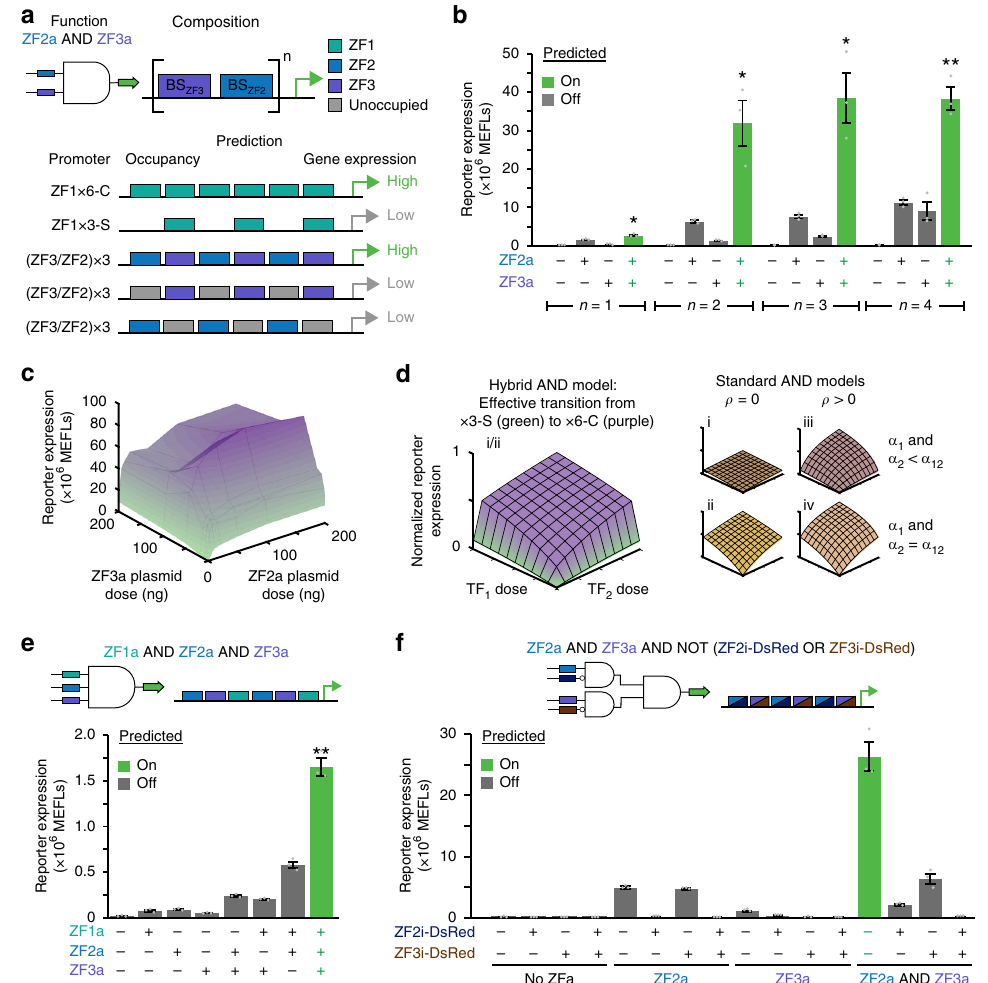
Fig. 8 Composing Boolean logic. a The cartoon summarizes a strategy for single-layer, promoter-based logic gates with ZF-TFs. We hypothesized that AND gate promoters could be designed by using multiple repeats of a paired ZF3/ZF2 motif. Full occupancy of this promoter by both ZF2a and ZF3a mimics a fully occupied x6-C promoter, and partial occupancy (with either ZFa alone) mimics an x3-S promoter. Thus, there is a large increase in gene expression when the promoter is occupied by two types of ZFa compared to one type. b Candidate two-input AND gates were constructed using one to four repeats of paired binding sites in the promoter. AND gate behavior is considered signi fi cant if reporter expression with both ZFa is greater than the sum of reporter expression with each ZFa individually (one-tailed Welch ’ s t -test: * p < 0.05, ** p < 0.01). c Two-input dose response for the AND gate with three repeats of paired binding sites. The landscape is shaded from green to purple to facilitate visualization in the z-axis direction. d A theoretical model of COMET AND behavior is compared with other models of transcriptional AND gates; the latter vary in whether activators have multiplicative cooperativity ( ρ ) and whether maximum activation ( α ) is equivalent for TFs individually and together (Methods). e A three-input AND gate was constructed using two repeats of a triplet binding site motif. AND gate behavior is considered signi fi cant if reporter expression with all three ZFa is greater than the sum of reporter expression with each ZFa individually, and also greater than the sum from each of the three combinations with two co-expressed ZFa and the other ZFa individually (one-tailed Welch ’ s t- test, ** p < 0.01 for all four of these tests). f A four-input gate was constructed using the binding site arrangement shown. Experiments were conducted in biologic triplicate, and data were analyzed as described in Methods. Error bars represent the S.E.M. Source data are provided in the Source Data fi